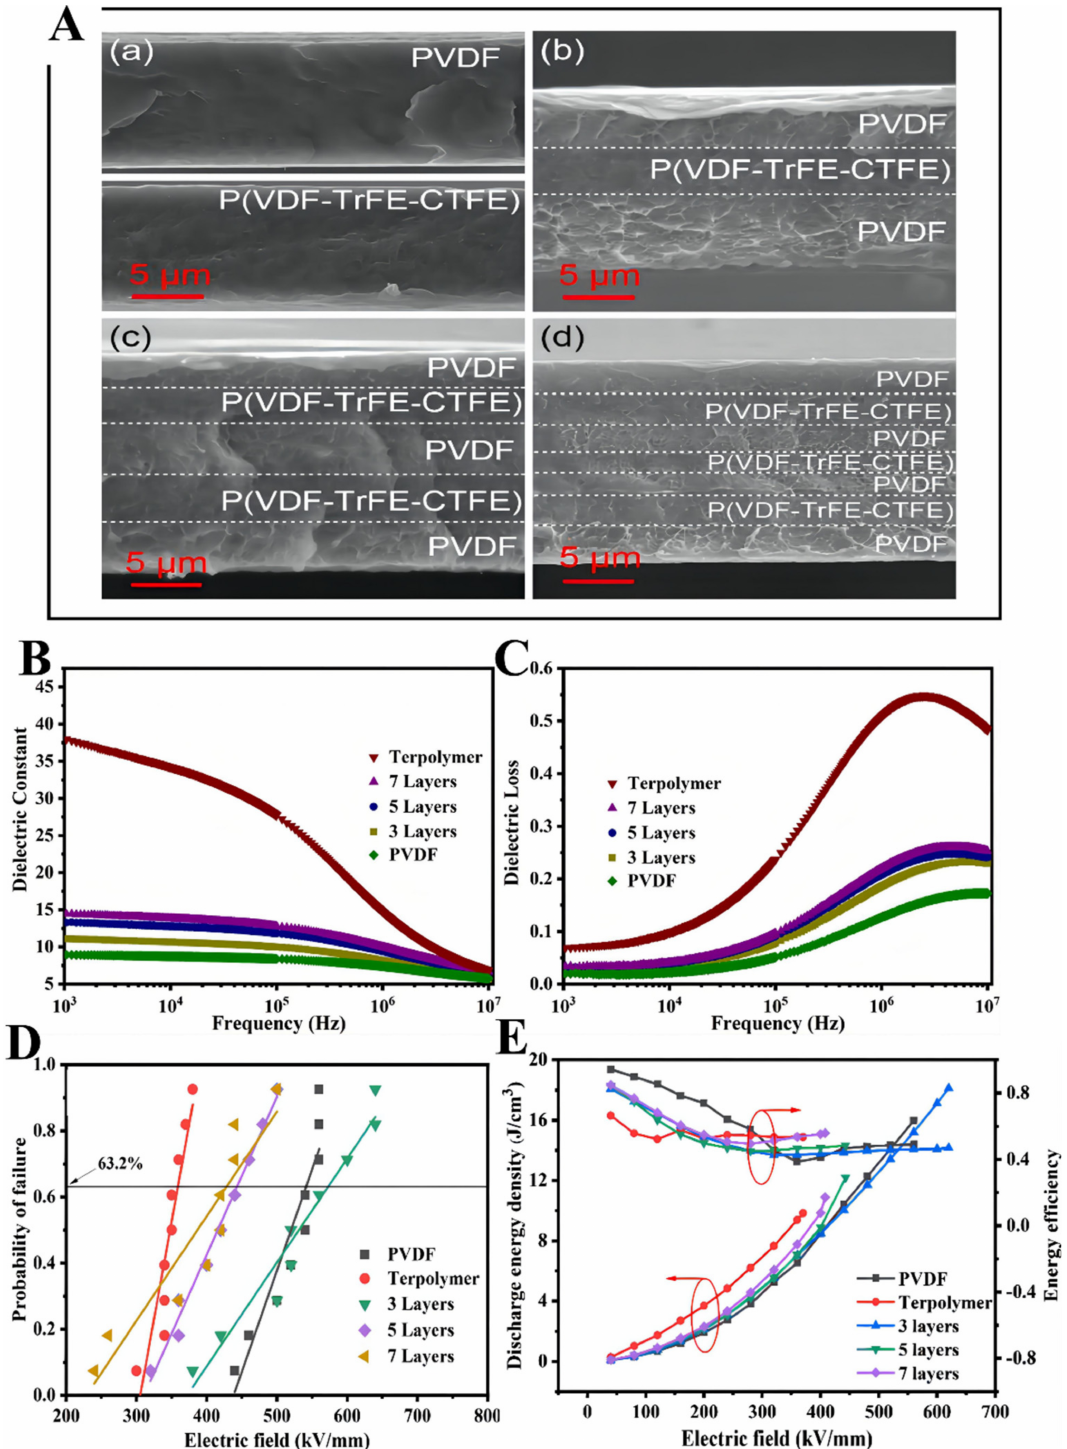
Figure 9. ( A ) SEM images of the cross-sections of ( a ) pure PVDF and P(VDF-TrFE-CTFE), ( b ) three- layer composites, ( c ) five-layer composites, and ( d ) seven-layer composites. ( B ) Dielectric constant and ( C ) dielectric loss of pure polymers and multilayer-structured composites as a function of frequency. ( D ) Weibull distribution of the breakdown strength. ( E ) Energy density and charge–discharge effi- ciency of pure polymers and multilayer-structured composites. Adapted with permission from [41], Copyright © 2022 American Chemical